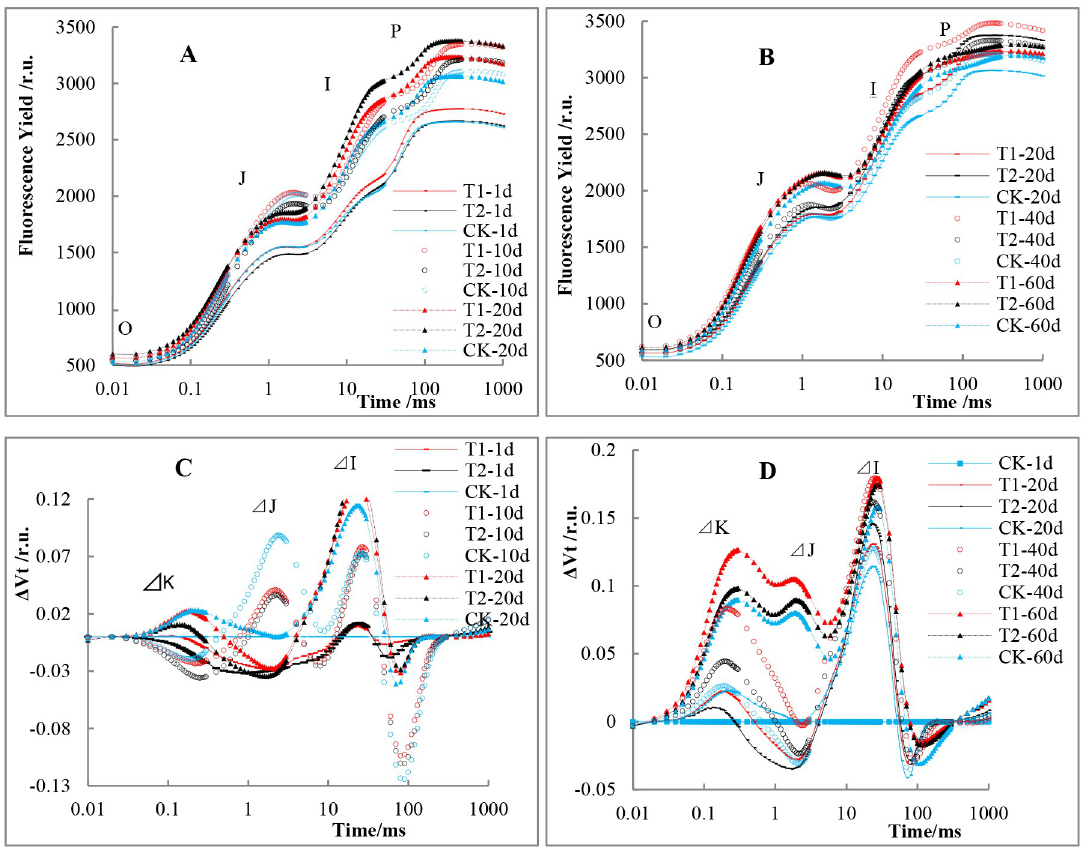
Fig 3. Effects of supplemental light on tomato rapid chlorophyll fluorescence induction kinetic curves. A and B: OJIP curves. C and D: Curves of differential values ( Δ V t ) resulting from subtracting the control value of the first measurement from the treatment values V t [ Δ V t = (F t − F 0 )/F v − V t CK) ]. A and C: Measurements from the first day to the 20 th day after the leaves fully unfolded. B and D; Measurements from the 20 th day to the 60 th day after the leaves fully unfolded. The values are the means (n = 10) ± SEs.